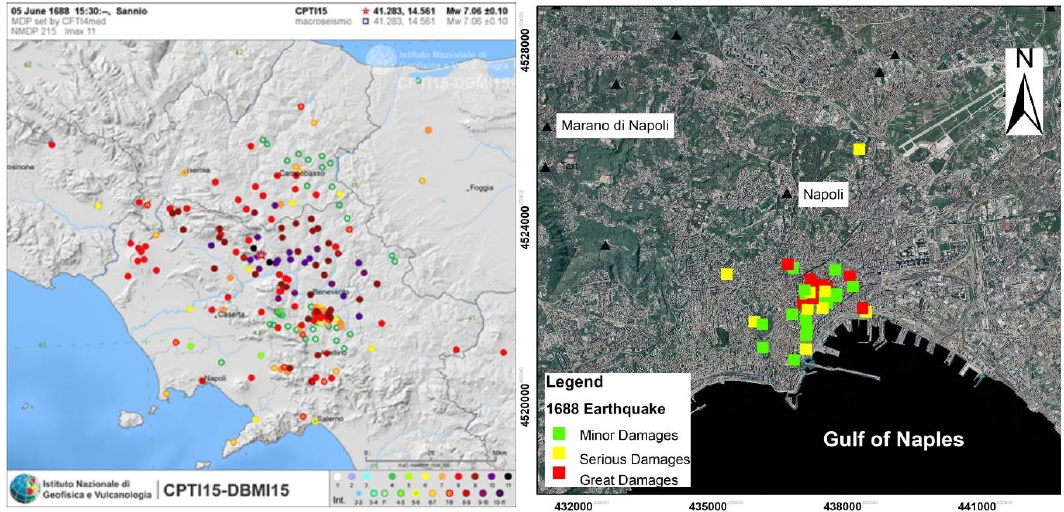
Figure 5. Map of the 1688 MCS macroseismic intensity (modified from [1]) on the left; map of the damage to Naples from the earthquake of 5 June 1688 on the right.